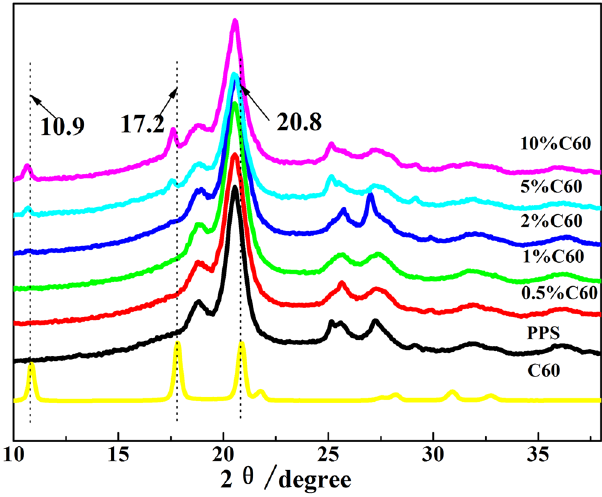
Figure 4. XRD spectra of C 60 , PPS and PPS/C 60 composite powder.